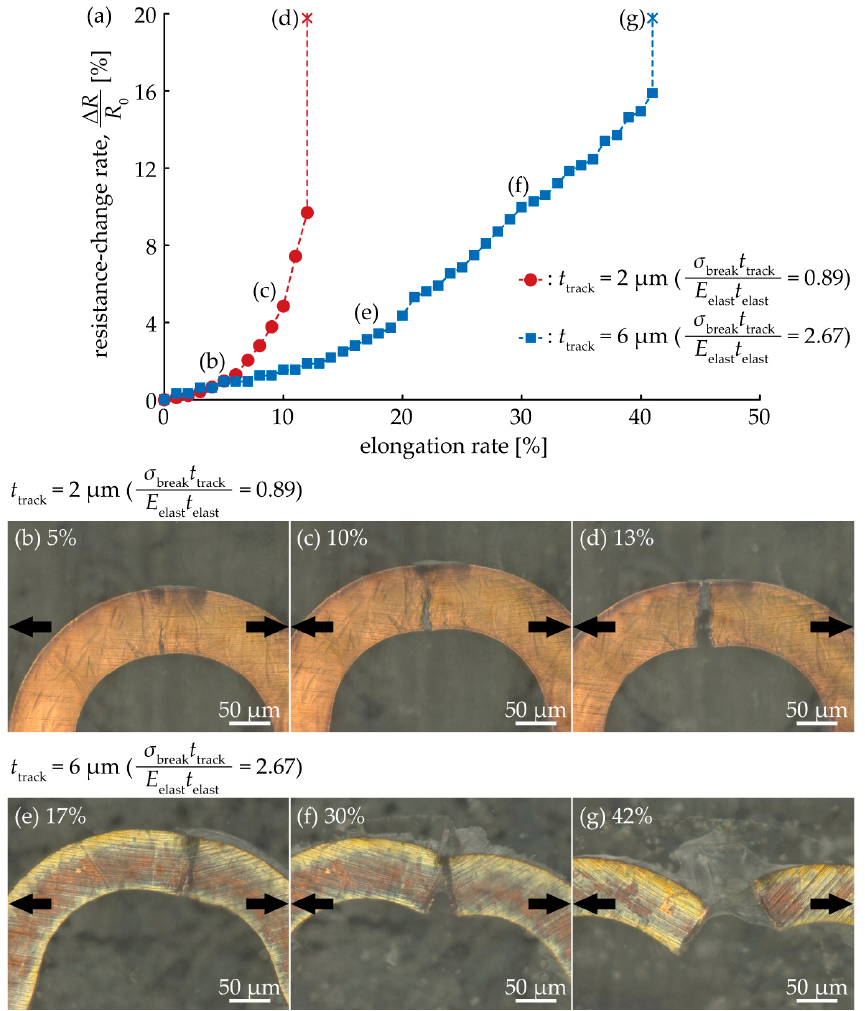
Figure 7. ( a ) Relationship between the resistance ‐ change rate and elongation rate for t track = 2 μ m and 4 μ m; Optical images around the apex of a wave shape for ( b – d ) t track = 2 μ m and ( e – g ) t track = 6 μ m. 4 µ m; Optical images around the apex of a wave shape for ( b – d ) t track = 2 µ m and ( e – g ) t track = 6 µ